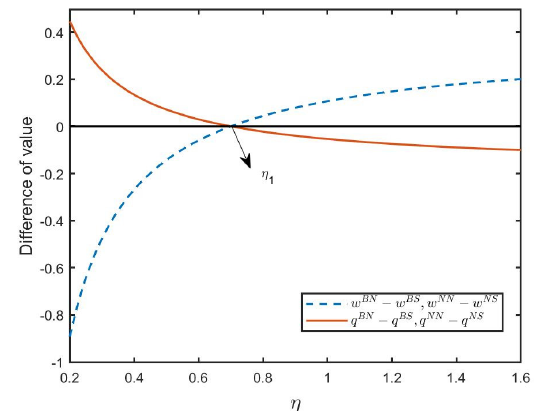
Figure 6. The impact of η on profit difference. ( α = 2.2, ε = 0.2, η = 0.9). ( E [ q iN ]) Lemma 1. ∂